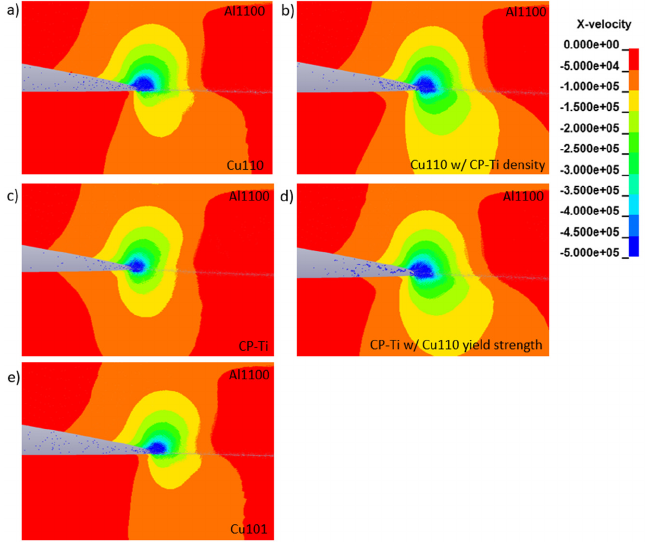
Figure 13. Shear velocities at the interfaces for Al1100 & ( a ) Cu110, ( b ) fictitious Cu110 with the density of CP-Ti, ( c ) CP-Ti, ( d ) fictitious CP-Ti with the yield strength of Cu110, and ( e ) Cu101.